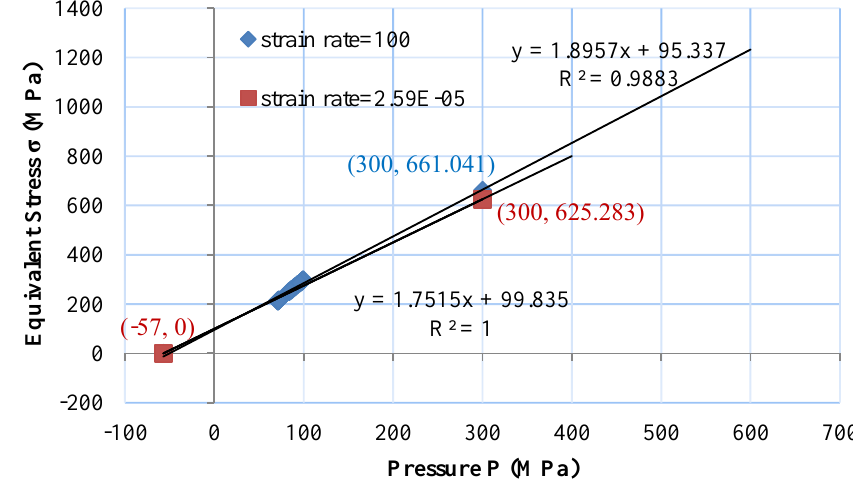
Figure 5. Linear relation of equivalent stress against pressure for two different strain rates.